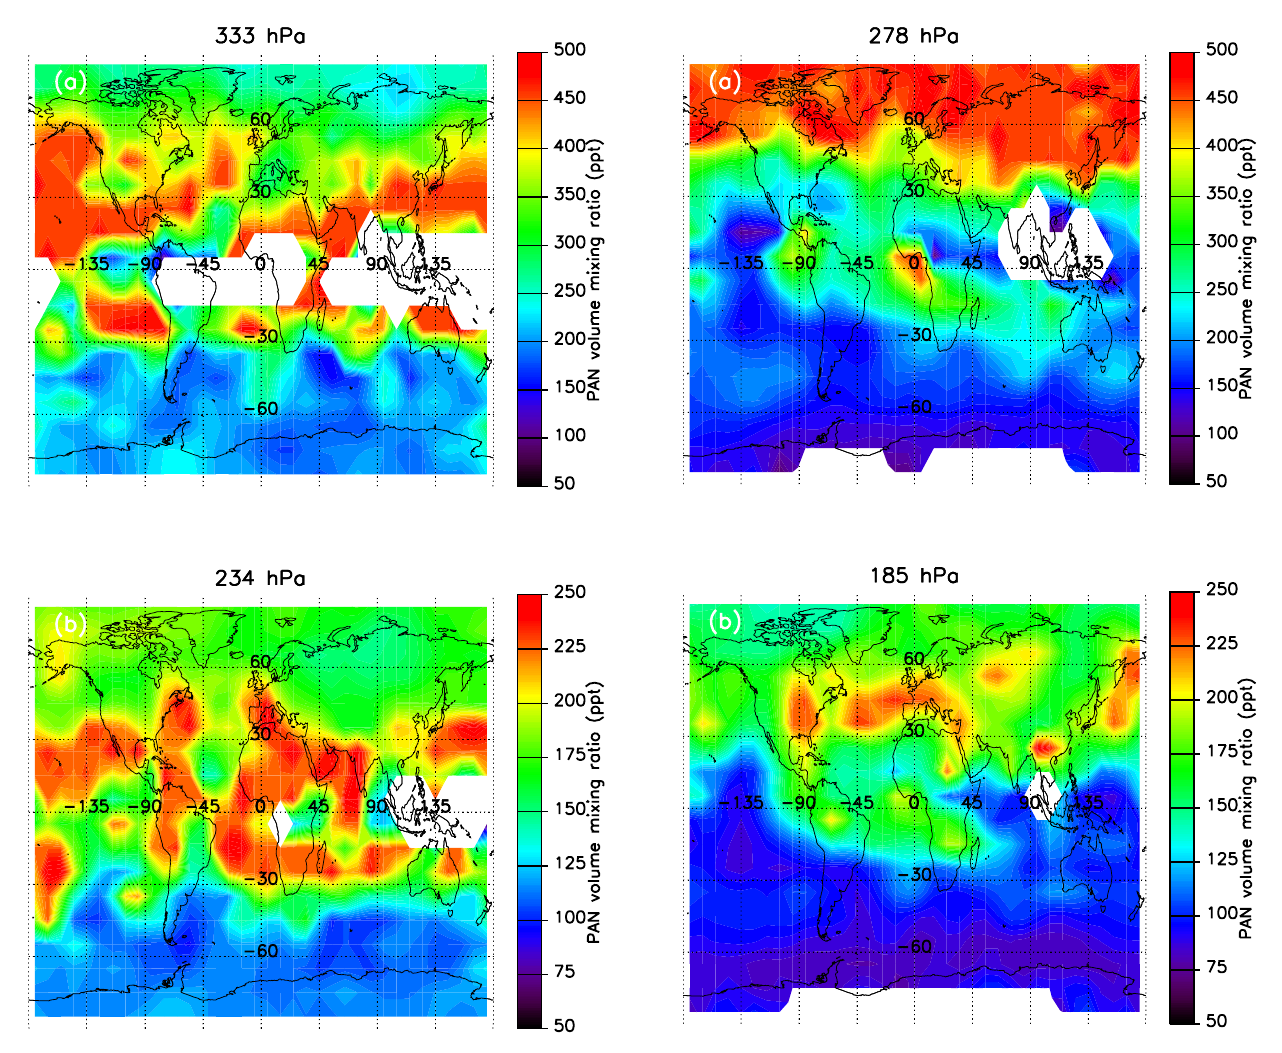
600 pptv in the monthly average at 333 hPa) and South-East Asia extending into the Central and Eastern Pacific